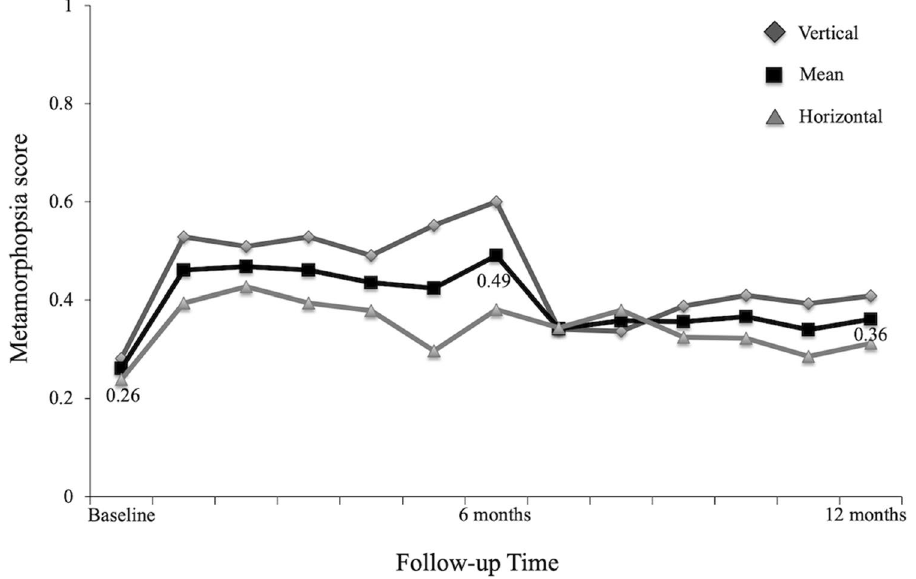
Figure 2. This is time course of changes in metamorphopsia in patients with branch retinal vein occlusion (BRVO) for 12 months. The mean metamorphopsia score did not improve with treatment ( P = 0.713) during 12 months. Similarly, vertical and horizontal metamorphopsia scores did not improve. Vertical metamorphopsia scores tended to be higher than horizontal metamorphopsia scores, but no significant difference was observed during the follow-up period.